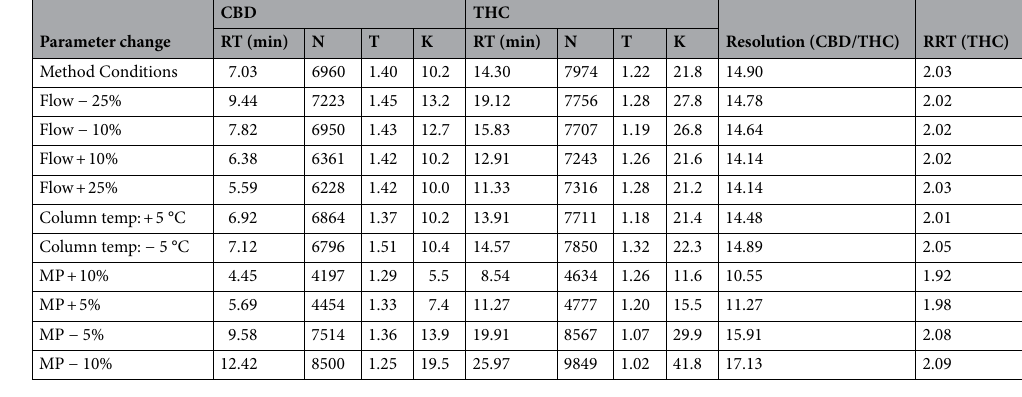
Table 3. Robustness test for HPLC parameter variations—CBD and THC assay method